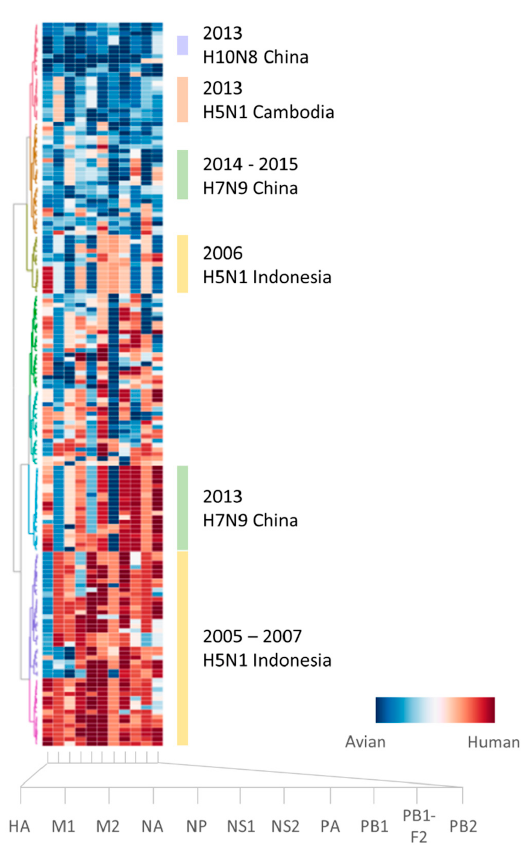
Figure A1. Hierarchical clustering of host tropism protein signatures of 160 confirmed zoonotic strains. Zoonotic strains from the same influenza outbreaks typically share similar signatures. Each row depicts the signature of a zoonotic strain, with host tropism predictions of 11 proteins shown in each column (HA, M1, M2, NA, NP, NS1, NS2, PA, PB1, PB1-F2, and PB2). Avian protein predictions are illustrated in blue while human proteins are in red. The confidence of the avian or human host tropism prediction is expressed by the intensity of the color, based on the prediction probability estimates found in Supplementary S1 and S2 datasets. Table A1. Total number of suspected and confirmed zoonotic strains with complete proteome identified from zoonotic influenza outbreaks.